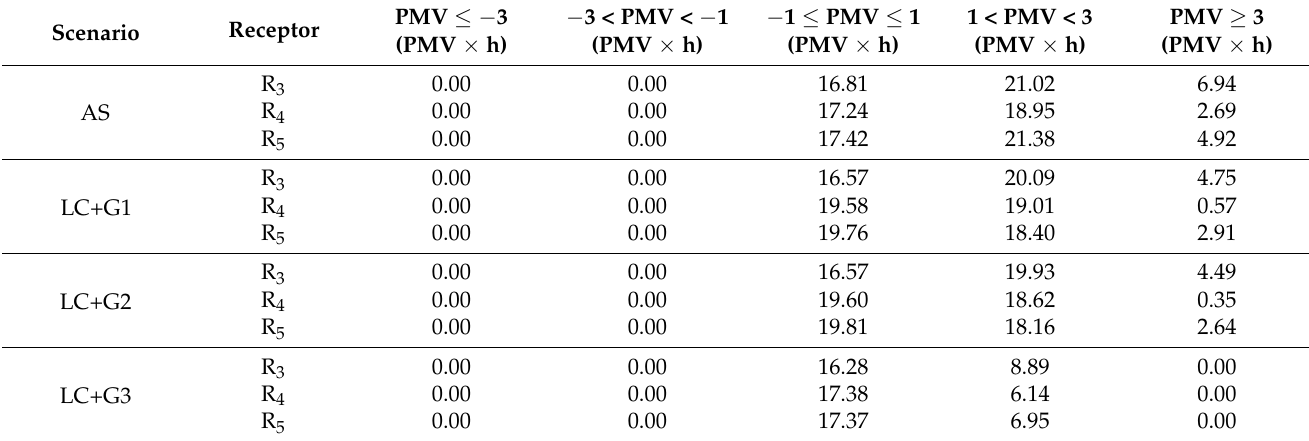
Table 7. PMV daily analysis of